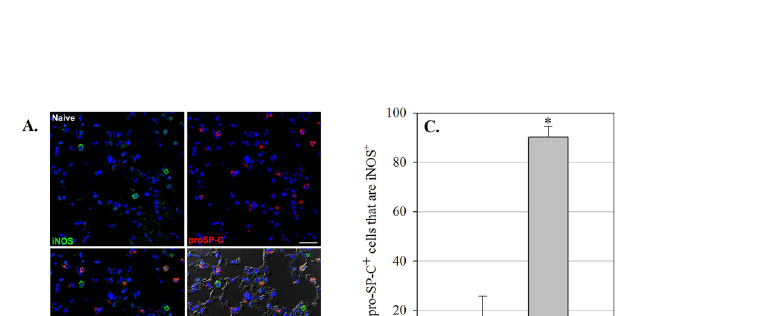
Fig 2. F . tularensis subspecies tularensis Schu S4-infected pulmonary epithelial cells are relatively resistant to the antimicrobial effects of cytokine treatment. (A) TC-1 lung epithelial cells were infected with Schu S4, and intracellular bacteria were enumerated after 72 h. Cultures were treated with recombinant cytokines immediately after infection as indicated, or untreated ( ‘ Schu S4 alone ’ ). (B) Changes in NOS2 gene expression in TC-1 cell cultures infected with Schu S4 and treated with recombinant cytokines. Fold induction values are expressed relative to ‘ Schu S4 alone ’ cultures. * = significantly different from cultures treated only with individual cytokines (P < 0.05). Data are expressed as mean ± SD of triplicate cultures, and plots are representative of two experiments of similar design.